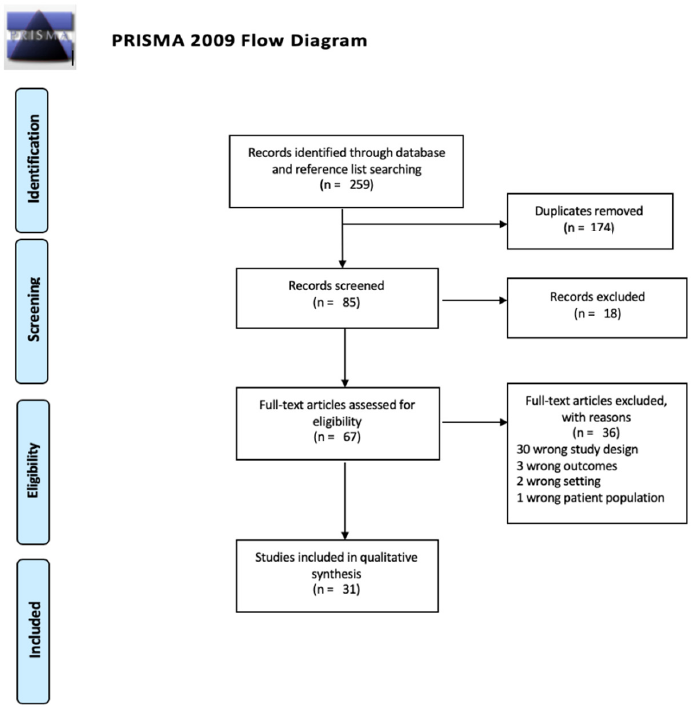
Figure 1. PRISMA diagram of search strategy and results [20].